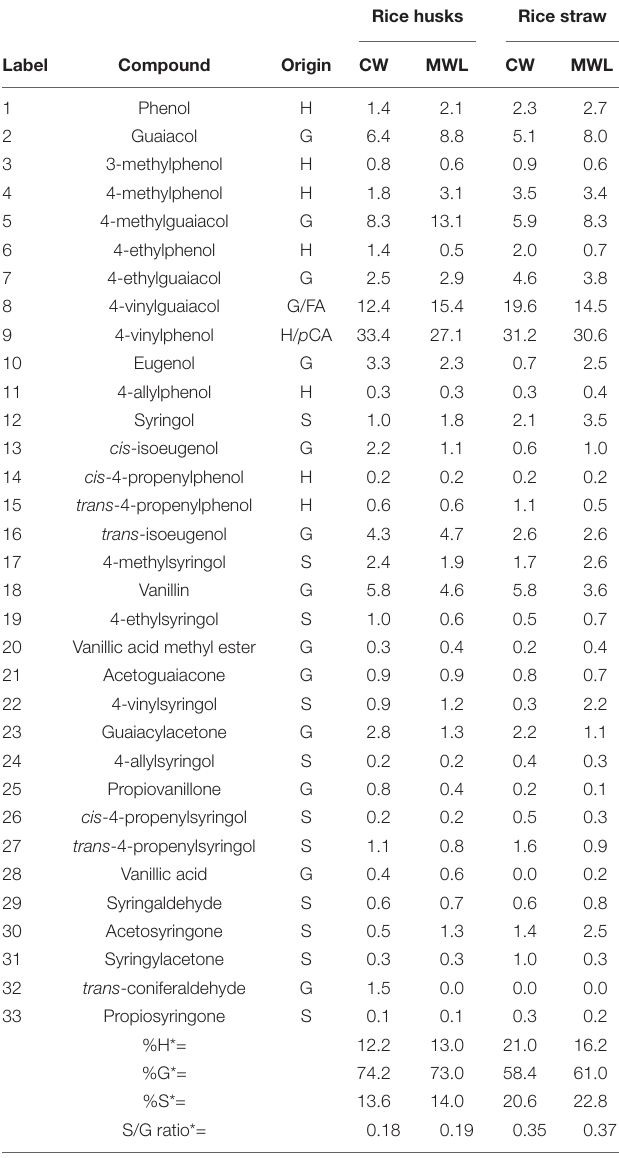
TABLE 2 | Identities and relative molar abundances of the compounds released after Py-GC/MS of whole cell walls (CW) of rice ( Oryza sativa L.) husks and straw and their respective isolated MWLs. Rice husks Rice